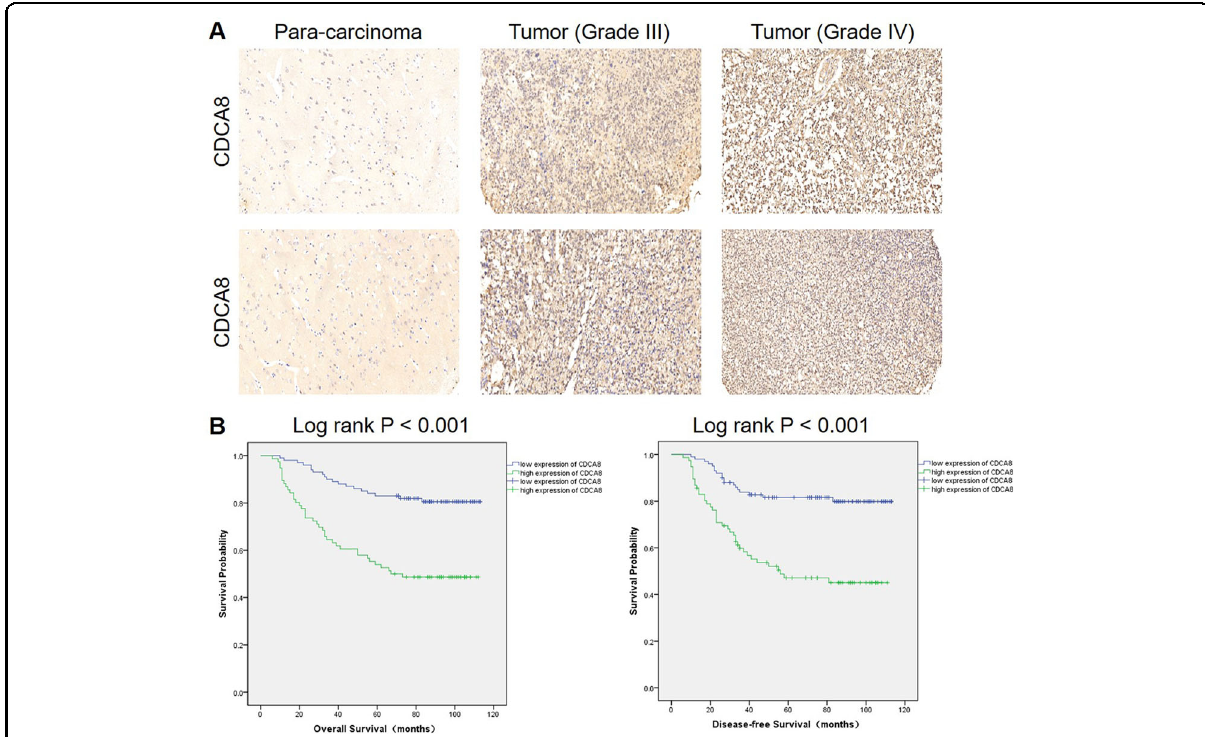
Fig. 1 High expression of CDCA8 in glioma predicts poor prognosis. A CDCA8 expression in para-carcinoma tissues and glioma tissues with different tumor grade. B Kaplan – Meier survival analysis of CDCA8 expression in glioma patients.